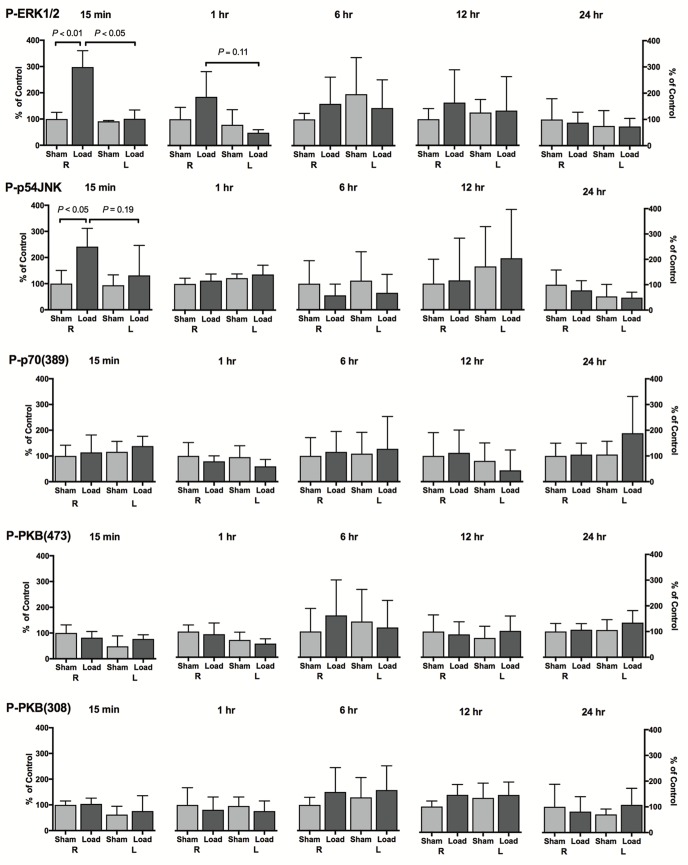
Signaling events in bone after a single period of mechanical loading.A cyclic compressive load was applied to the right antebrachium for 1,500 cycles at a peak strain of −3750με using a haversine waveform at 4Hz and a peak load of −18.0 N. Significant increases were noted in phosphorylation of ERK and p54JNK in the right loaded ulnae compared to sham controls as measured by Western blot analysis. All data is expressed as a percentage of the right sham control limb.